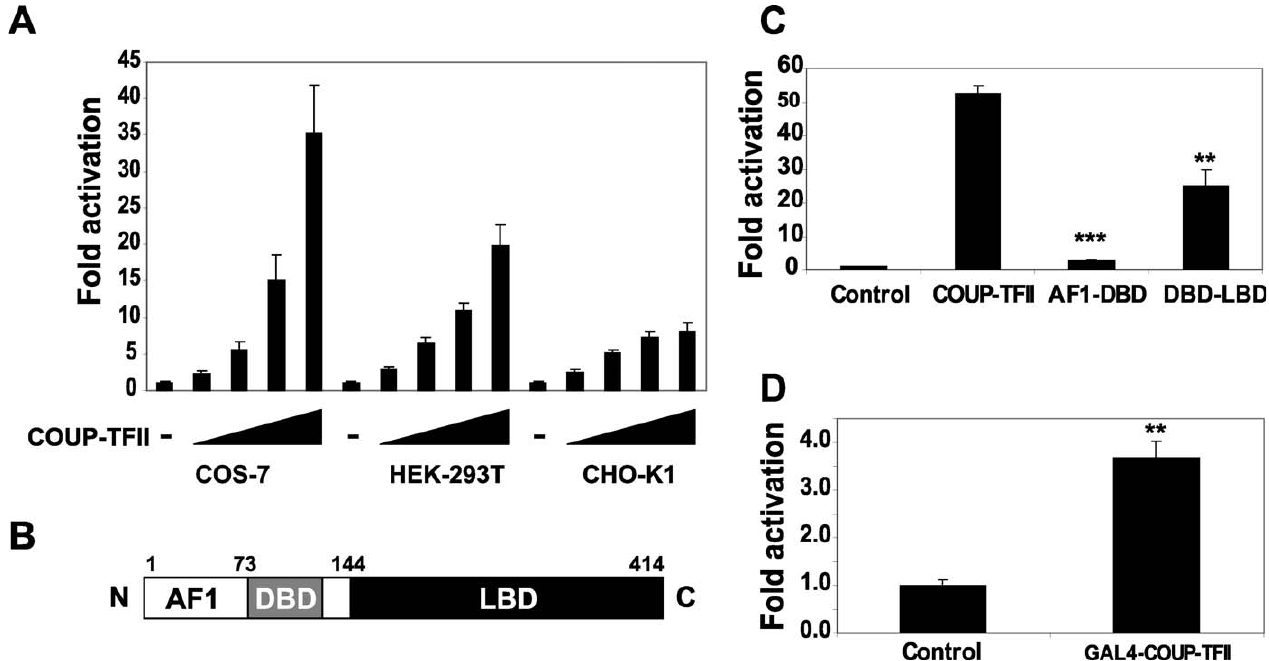
Figure 2. COUP-TFII Acts as an Activator of Transcription in Multiple Cell Lines (A) Activation of the NGFI-A promoter reporter construct with increasing concentrations of COUP-TFII (0ng, 50ng, 100ng, 150ng, and 200 ng of the expression vector, respectively, for each cell line). (B) Domain structure of COUP-TFII. (C) Effects of the COUP-TFII deletion mutants on activation of the NGFI-A promoter-driven reporter. The AF1-DBD construct activates ; 2-fold above empty vector control. (D) Activation by the GAL4-DBD-COUP-TFII-LBD. The fold activation is the relative fly luciferase activity of the NGFI-A promoter induced by COUP-TFII versus the control vector without COUP-TFII. All data are normalized to the activity of Renilla luciferase that was used as transfection control. For statistical analysis, the fold induction was compared with full-length COUP-TFII or GAL4-DBD in (C) and (D), respectively. doi:10.1371/journal.pbio.0060227.g002 PLoS Biology |